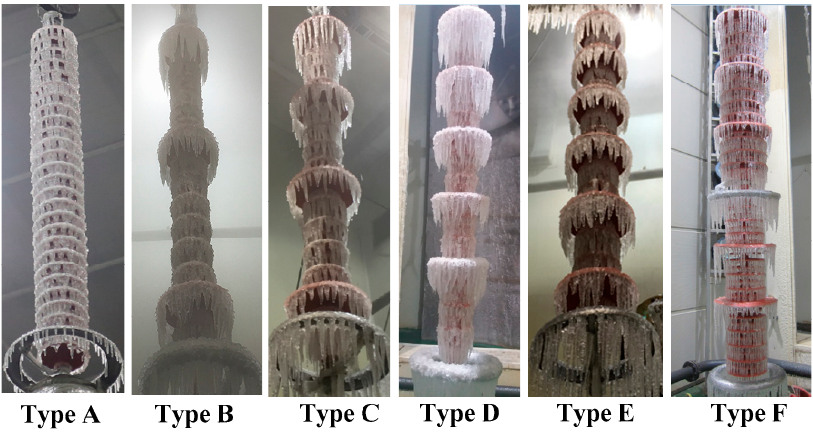
Figure 5. Appearance of the iced specimens when ice thickness d = 15 mm. Table 3. U 50 (kV) for the test specimens under different icing degrees.